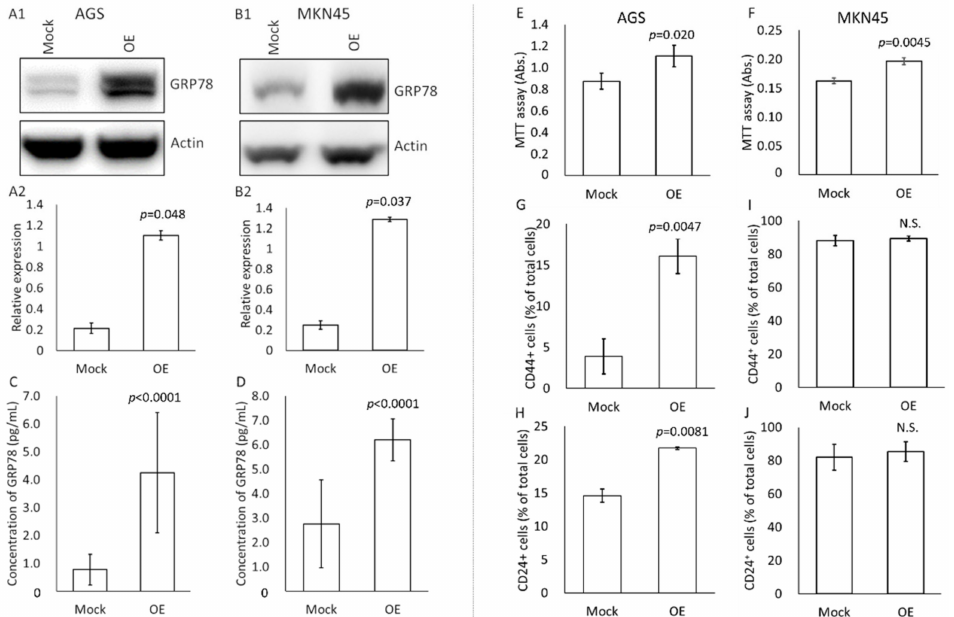
Figure 3. Effects of the application of GRP78-containing exosomes on changes in profiles of cultured gastric cancer cells. ( A , B ) Western blotting for GRP78 using cell disruption solutions of AGS ( A1 ) and MKN45 ( B1 ) mock and GRP78-overexpressed (OE) cells. Relative expression levels of GRP78 compared with actin expression in AGS ( A2 ) and MKN45 ( B2 ) mock and GRP78-OE cells. n = 3 each. ( C ) Thio- NAD cycling ELISA for GRP78 in exosomes derived from AGS mock and GRP78-OE cells. n = 3 each. ( D ) Thio-NAD cycling ELISA for GRP78 in exosomes derived from MKN45 mock and GRP78-OE cells. n = 4 each. ( E ) MTT assays for cell viability of AGS cells by application of exosomes isolated from AGS mock and GRP78-OE cells. n = 4 each. ( F ) MTT assays for cell viability of MKN45 cells by application of exosomes isolated from MKN45 mock and GRP78-OE cells. n = 3 each. ( G , H ) Flow cytometry assays (stemness measurements) for ( G ) CD44-positive and ( H ) CD24-positive cells in AGS by application of exosomes isolated from AGS mock and GRP78-OE cells. n = 3 each. ( I , J ) Flow cytometry assays (stemness measurements) for ( I ) CD44-positive and ( J ) CD24-positive cells in MKN45 cells by application of exosomes isolated from MKN45 mock and GRP78-OE cells. n = 3